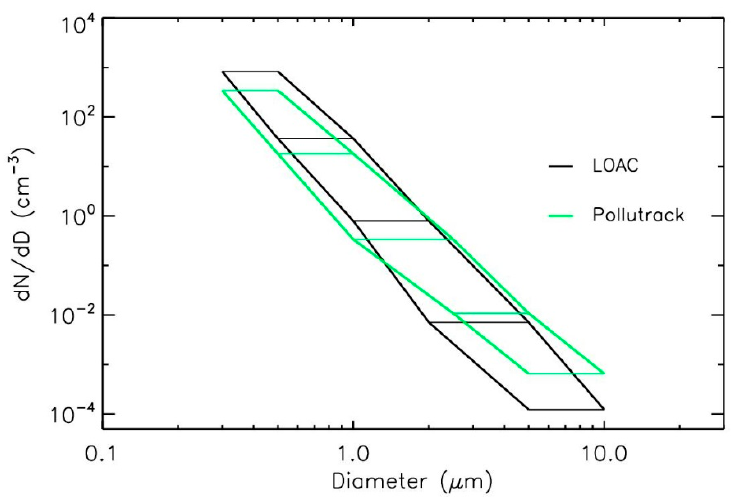
Figure 10. Mean size distribution for the mobile Pollutrack sensors around the “Park André Citroën” and LOAC at the “Ballon de Paris Generali” for the 27 March 2019–26 March 2020 period.